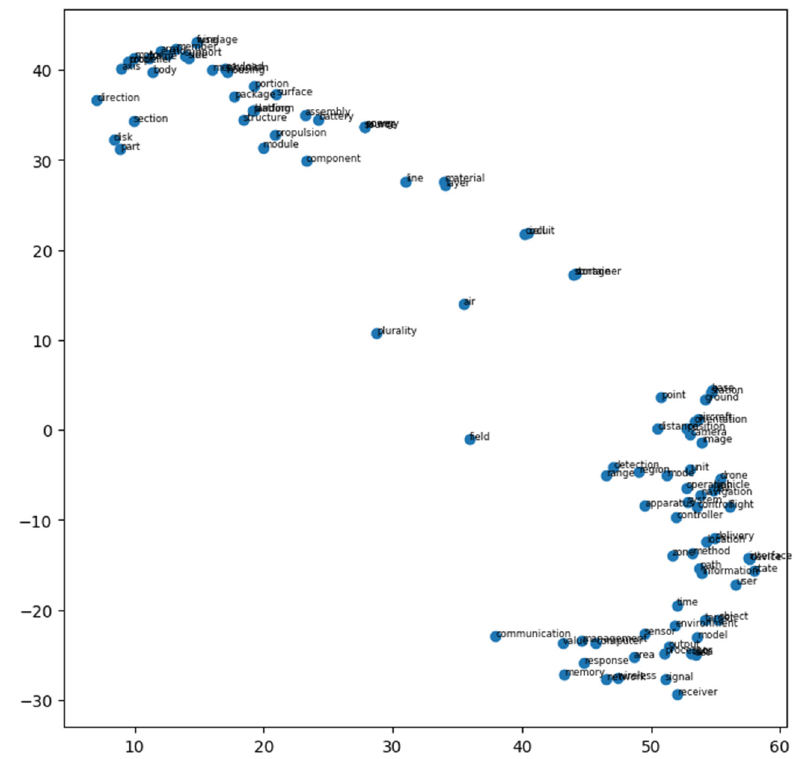
Figure 8. Example of word embedding results.